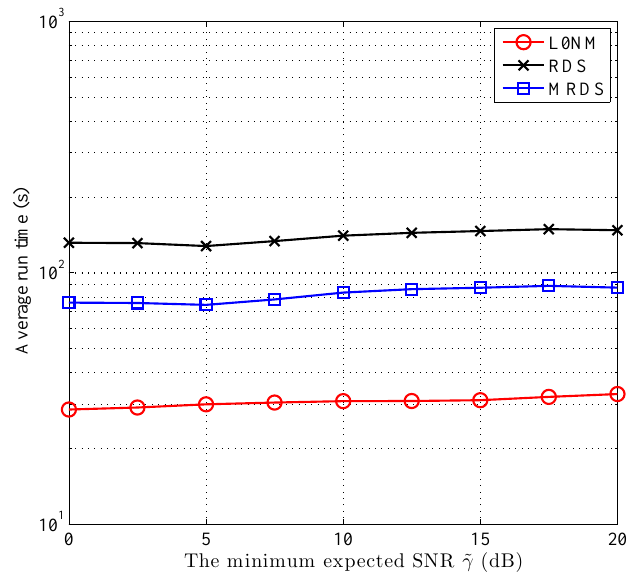
Figure 3. The average run time of our algorithms versus the SNR